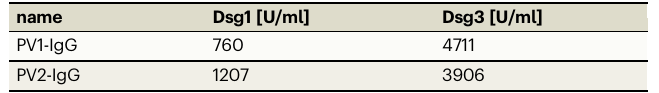
F , G Quanti fi cation of cytokeratin fl uorescence intensity in small areas perpen- dicular to the respective cell border. F Average of keratin fl uorescence intensity measured along 10 µ m spanning a cell border under respective conditions. G Apremilast improved PV1-IgG-induced increase in distance of fl uorescence PV1-IgG induced loss of co-localization between keratin fi laments and Dsg3 ( n =4). Columns indicate mean value±SEM, * P <0.05 (exact values are depicted in the fi gure). One-way ANOVA with Bonferroni correction. Source data are provided as a Source Data fi le.